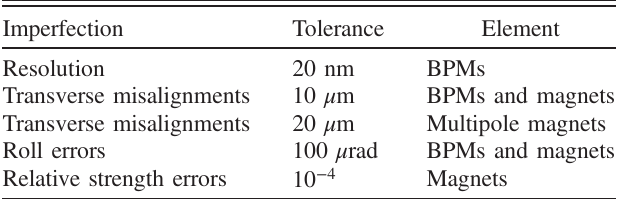
TABLE II. Tolerances used as rms values for the applied static imperfections in the final-focus